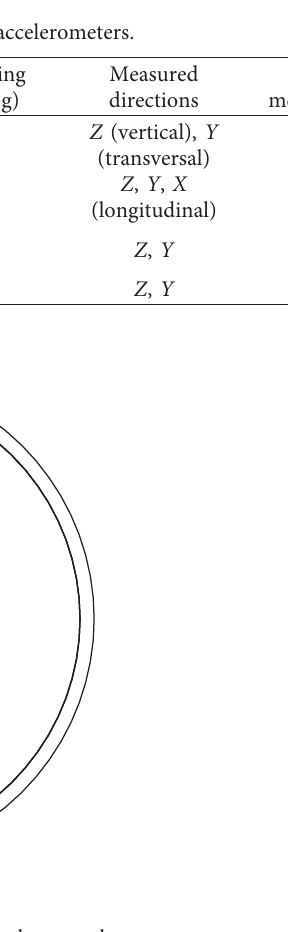
Figure 3: Diagram of measurement points in the